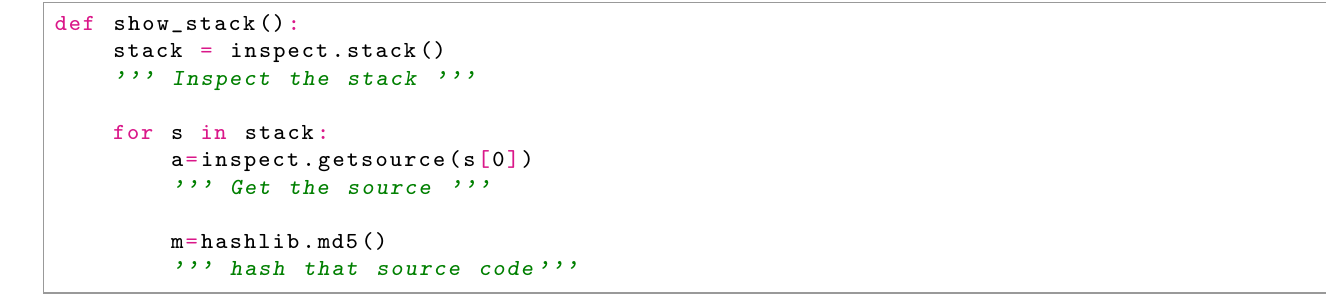
Figure 4. An example of using reflection in python language.